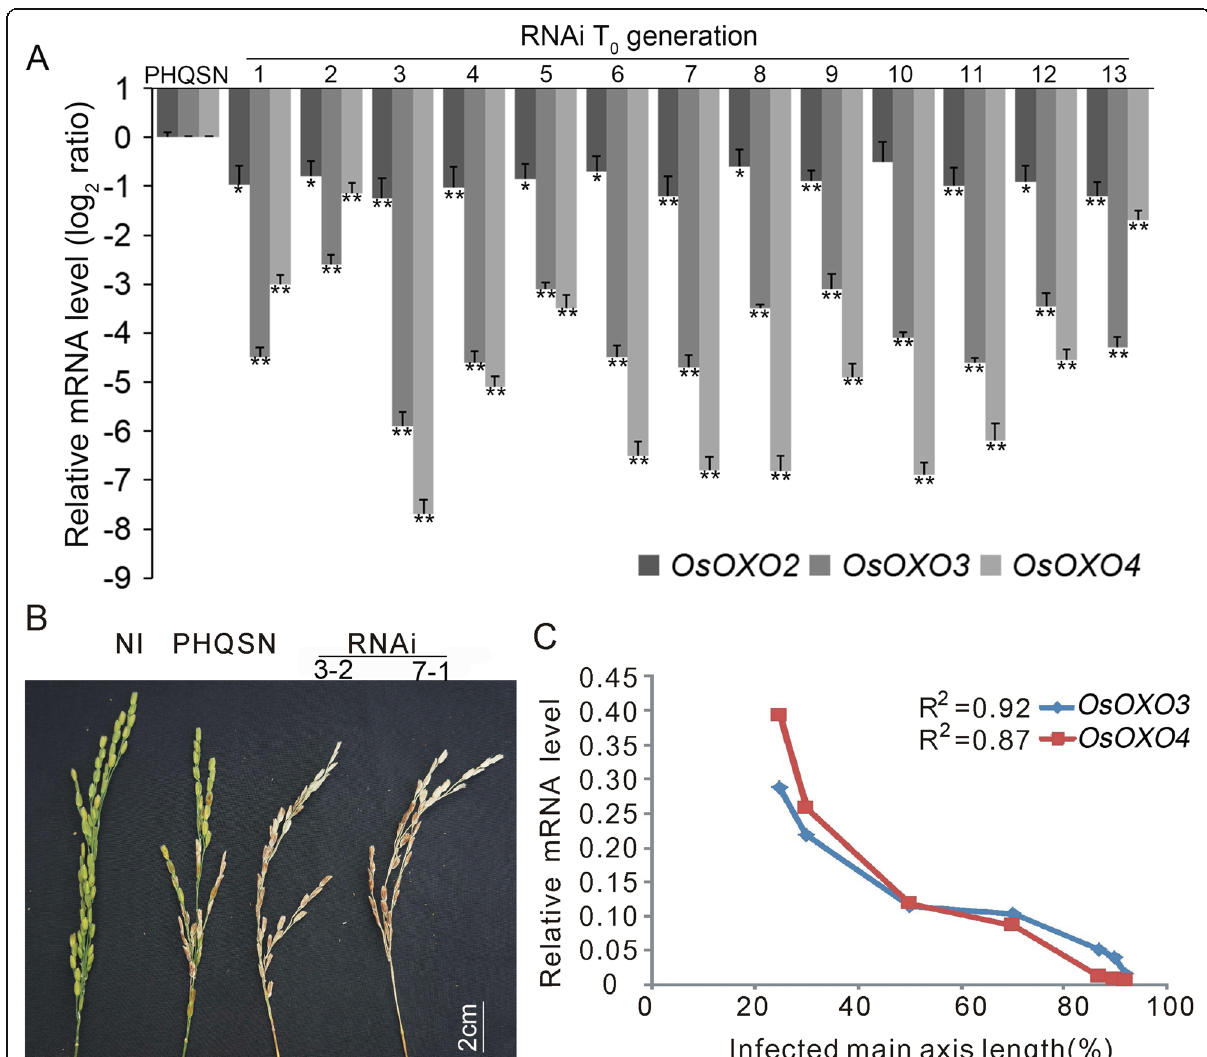
Fig. 3 The disease phenotypes of OXO silencing (RNAi) plants after panicle blast infection. a Transcription analysis of OsOXO2 , OsOXO3 and OsOXO4 in the RNAi plants by quantitative RT-PCR.Error bars indicate the standard deviation (SD) from three biological replicates and asterisks indicate statistically significant differences compared with ck (PHQSN) ( t test, ** P < 0.01, * P < 0.05). b Disease phenotypes of the RNAi and control (PHQSN) plants at the heading stage after inoculation with M. oryzae using the cotton-wrapping method. NI indicates the non-inoculation panicle. c Correlation analysis between decreased resistance and the expression levels of OsOXO3 and OsOXO4 in the RNAi plants after panicle blast inoculation. The correlation coefficient is calculated by linear regression